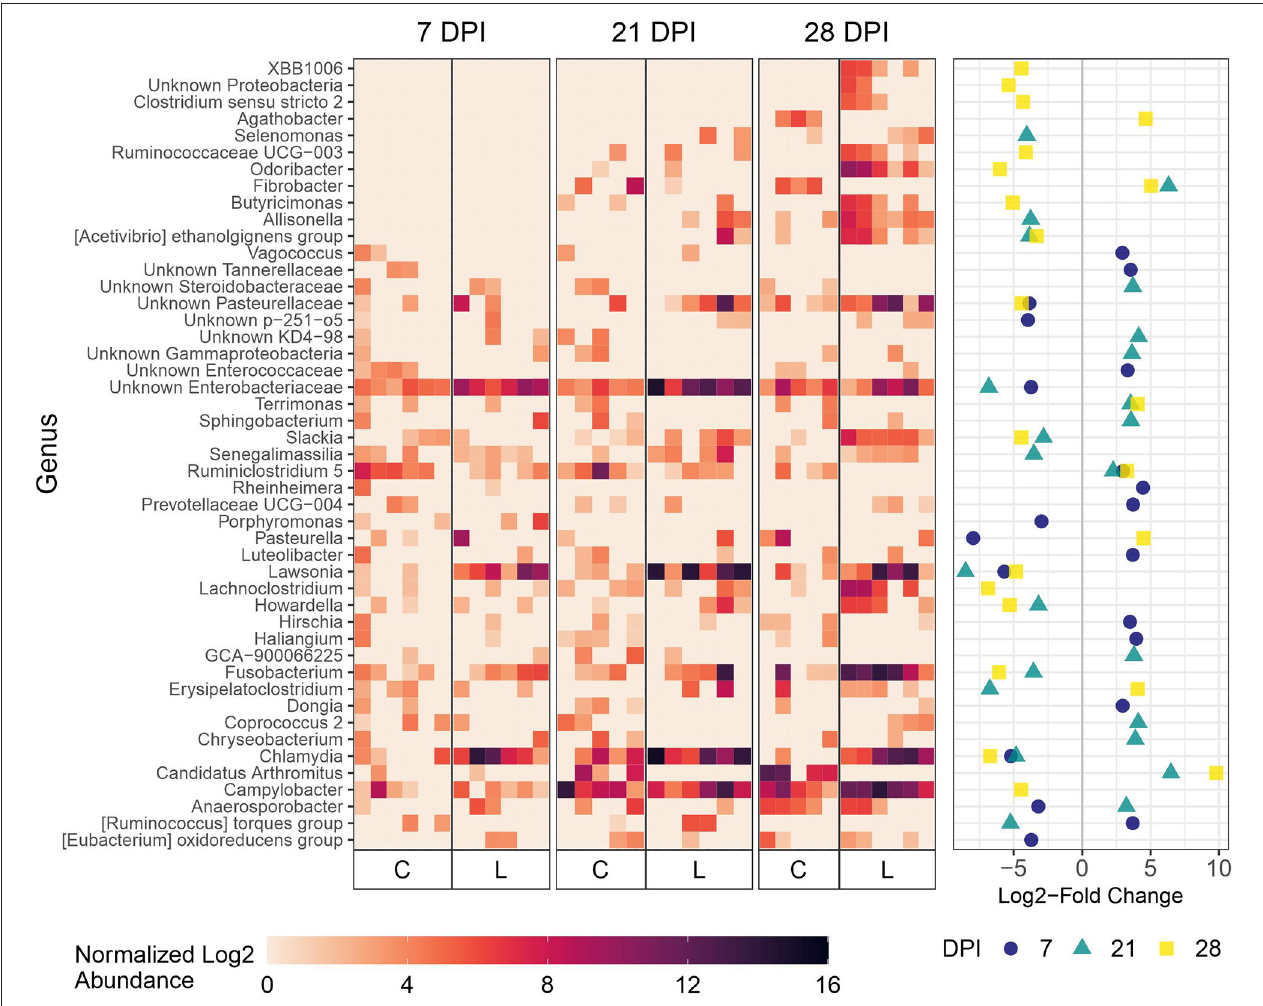
FIGURE 3 | Differential abundance of microbial genera in ileal mucosa between the Law (L) and Control (C) groups at 7, 21, and 28 dpi. The 20 genera with the largest significant log2-fold change at each dpi are included. The heatmap shows the cumulative sum scaling (CSS)-normalized log2 abundance of each genera per sample, with the significant log2-fold changes by dpi plotted on the right panel. Note that a genus only has to be one of the top 20 significantly differentially abundant at 1 dpi for it to be included in the figure. A positive log2-fold change indicates greater abundance in the Control group, and a negative log2-fold change indicates greater abundance in the Law